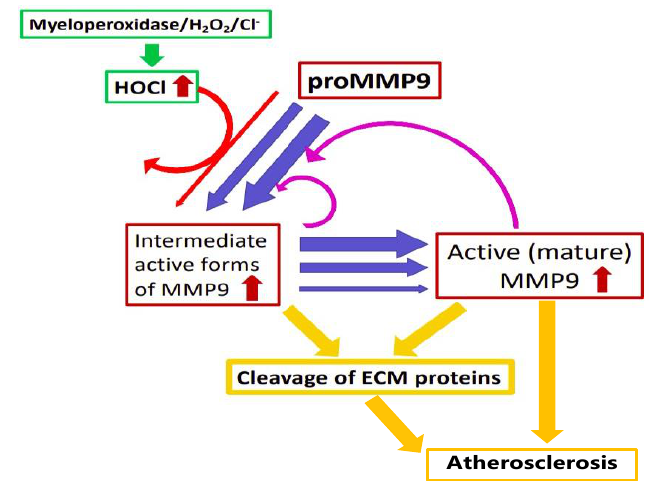
Figure 12. HOCl generated by the myeloperoxidase/H 2 O 2 /Cl − enzyme system, or reagent HOCl, can convert inactive proMMP9 to active intermediate forms of MMP9 (red arrows). These undergo subsequent further processing (possibly involving further oxidation or proteolysis) to active mature MMP9 (blue arrows). The active forms of MMP9 can catalyze the further proteolytic conversion of proMMP9 to active forms (pink arrows), resulting in an increasing cycle of activation of MMP9 (as indicated by the lines of increasing thickness) and the cleavage of target ECM proteins, including collagens IV and V (yellow arrows), exacerbating tissue damage and diseases, such as